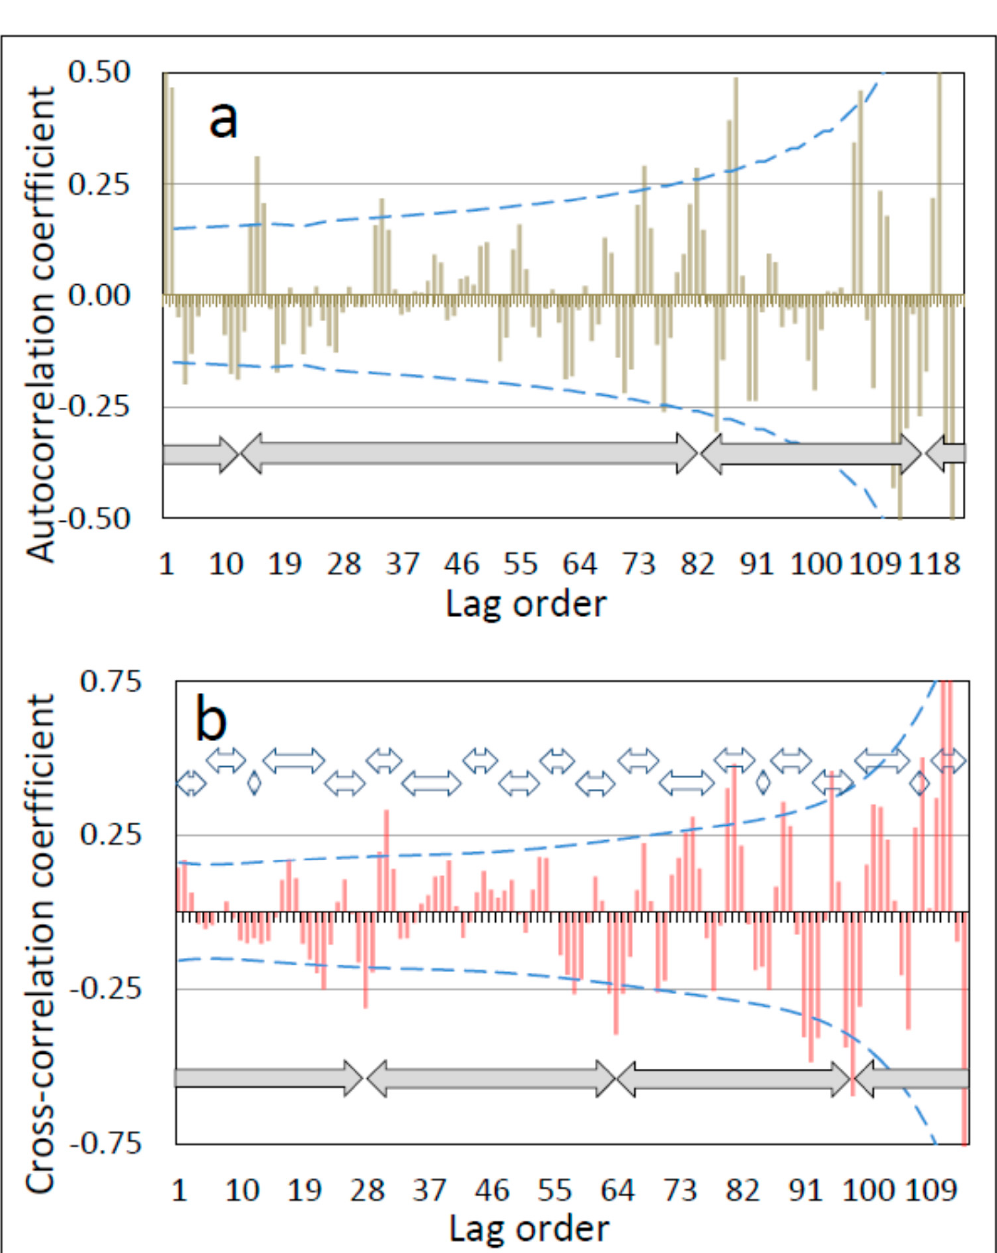
Figure 5. Auto- and cross-correlograms for dust-flux at EPICA Dome C (EDC, brown curve) and temperature at nearby Vostok (red curve) for the time period 4009–397 years before 1950 (Yb1950). ( a ) Discernible periodicity in lagged autocorrelation of dust flux. ( b ) Periodicity in cross-correlation between dust- and temperature-proxies over the same time period. The dashed blue lines represent 95% confidence limits (positive and negative) for the value of the correlation coefficient associated with different lag orders (sample sizes). The horizontal open double headed arrows demarcate centennial-scale repetition frequencies, while the longer, millennial-scale periodicities are visible as modulations of the correlation coefficients at periodicities of millennial scale (filled arrows; see text).